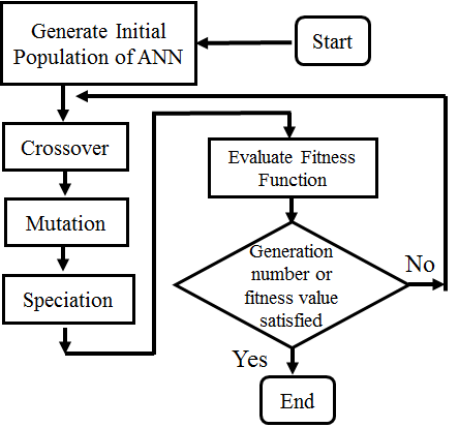
Figure 5. Workflow of NEAT.